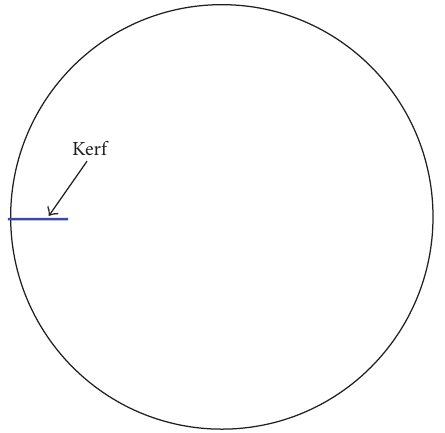
Figure 17: Description of damage on the shell.